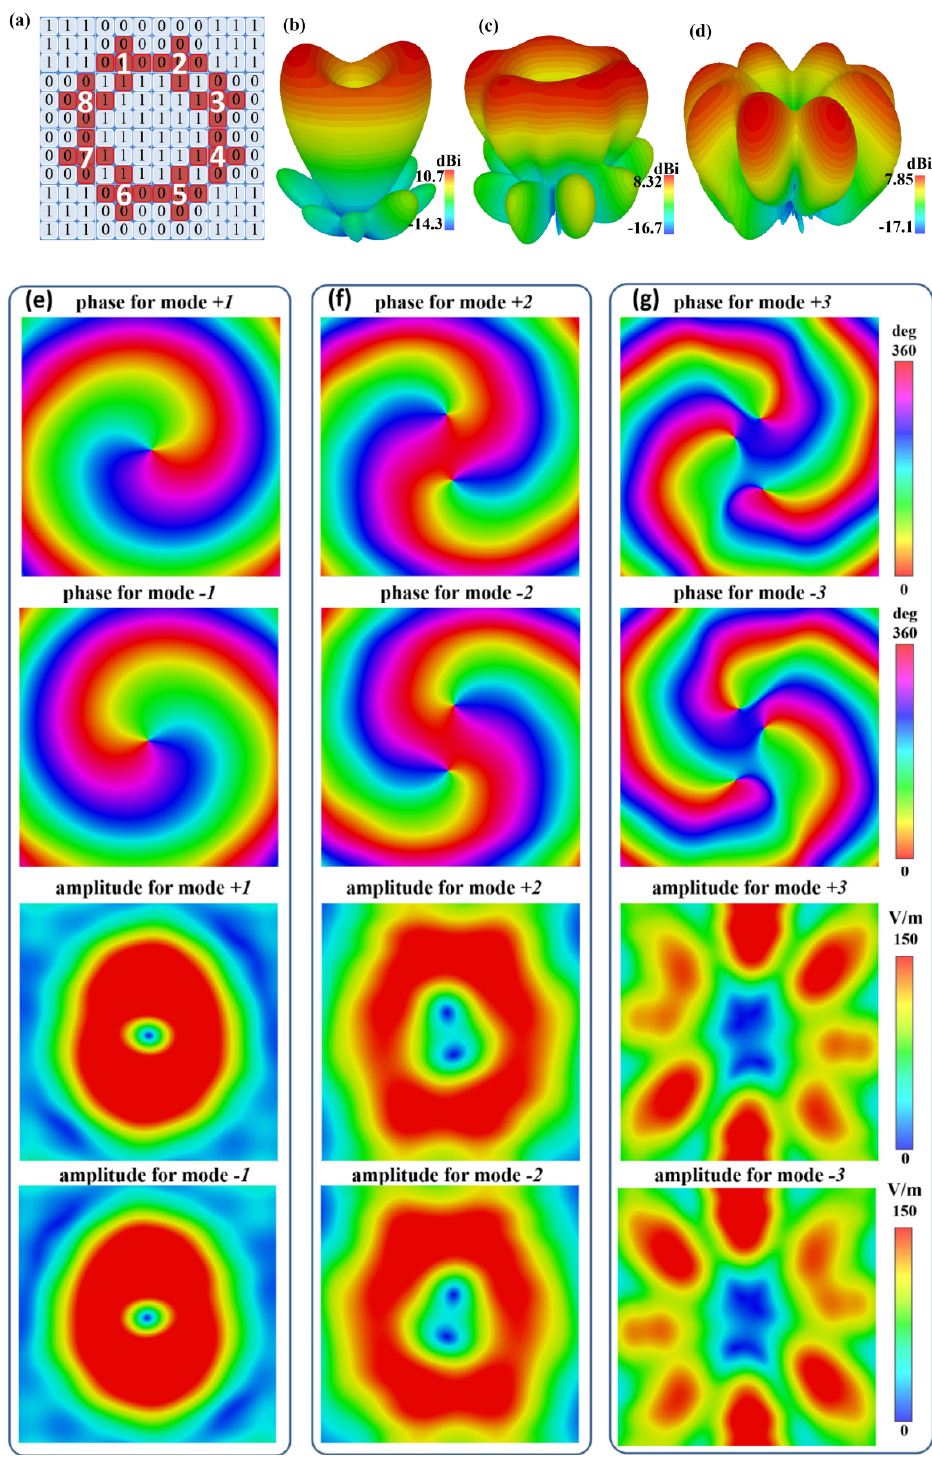
Figure 6. Diagram of the feeding positions and simulated results of OAM for the CFMS. ( a ) Diagram of the feeding positions. The eight subarrays were chosen to generate the OAM beam. ( b – d ) 3D radiation patterns of the OAM with 1, 2, 3 modes. ( e – g ) Phase and magnitude results of near electric field distributions on plane for the CFMS with the OAM in different modes. The OAM beams in +1, +2, and +3 mode can be respectively realized as the incident phases in an anticlockwise feeding phase with 45-, 90-, and 135-degree rotation. Correspondingly, the OAM beams in − 1, − 2, and − 3 modes were achieved as the incident phases with clockwise 45-, 90-, and 135-degree rotation.